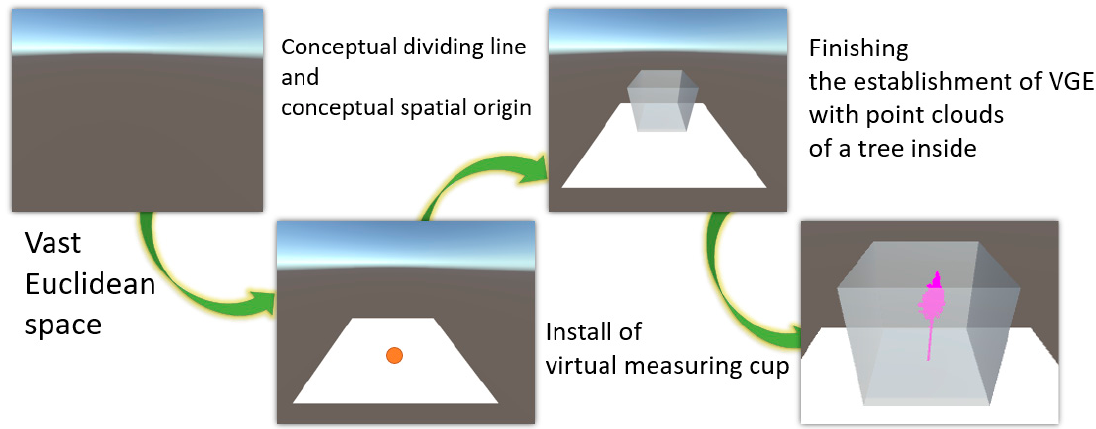
Figure 4. The steps of the establishment of the virtual geographic environment (VGE) for virtual water displacement (VWD).